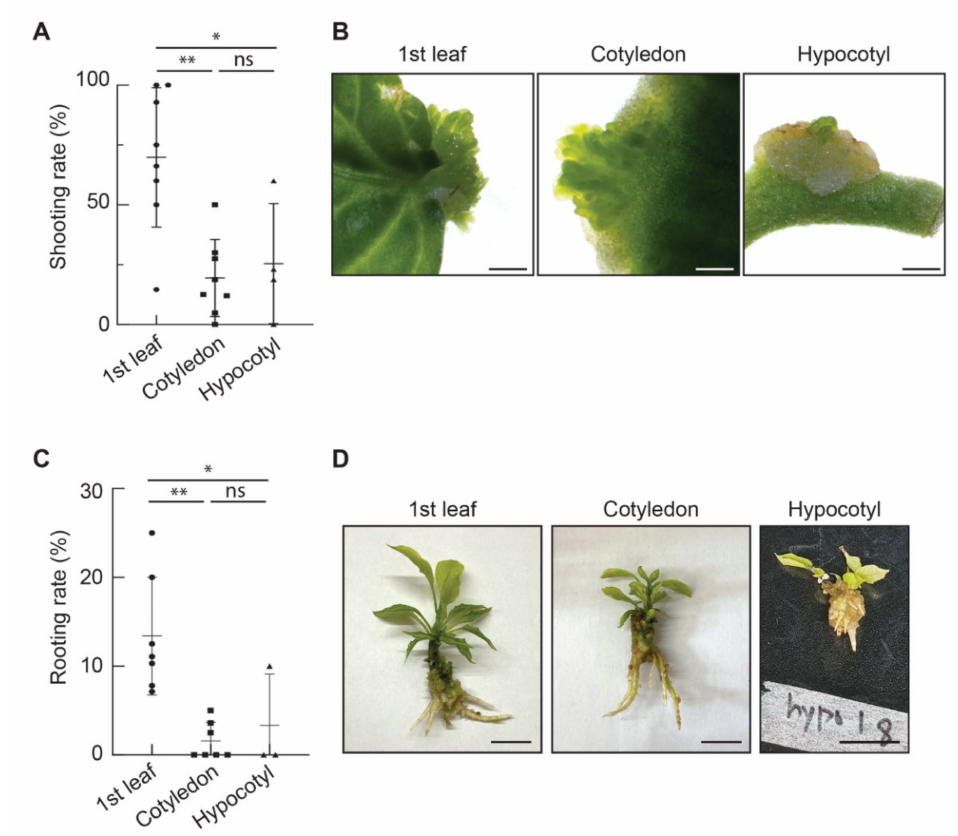
Figure 2. Comparison of organogenesis efficiencies among three explant types in Capsicum annuum L. ‘Dempsey’. ( A ) The graph of shooting rates of three explant types; first leaves, cotyledons and hypocotyls. ( B ) The images of shoot buds from the first leaf, a cotyledon and a hypocotyl. scale bars = 1 mm. ( C ) The graph of rooting rates of shoots obtained from three explant types; first leaves, cotyledons and hypocotyls. ( D ) The images of shoots with protruded roots from three explant types. scale bars = 1 cm, the dots in the graphs indicate the number of biological replicates. This study used a total of 234 first leaves, 285 cotyledons and 67 hypocotyls from 69 Dempsey plants. ns, non-significant difference; *, p < 0.05; **, p < 0.01 based on analysis of variance